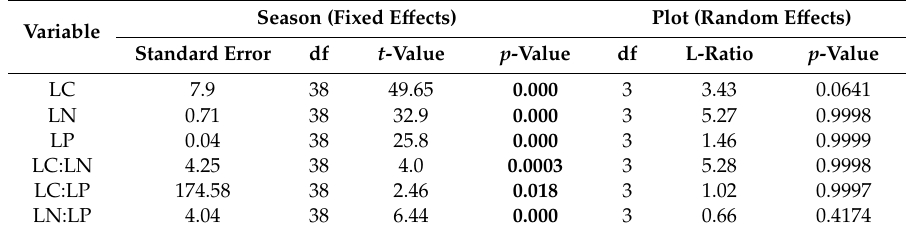
Table 3. Linear mixed effect model results of the effects of season and plot on leaf stoichiometry of P. australis . Season (Fixed E ff ects) Plot (Random E ff ects) Variable Standard